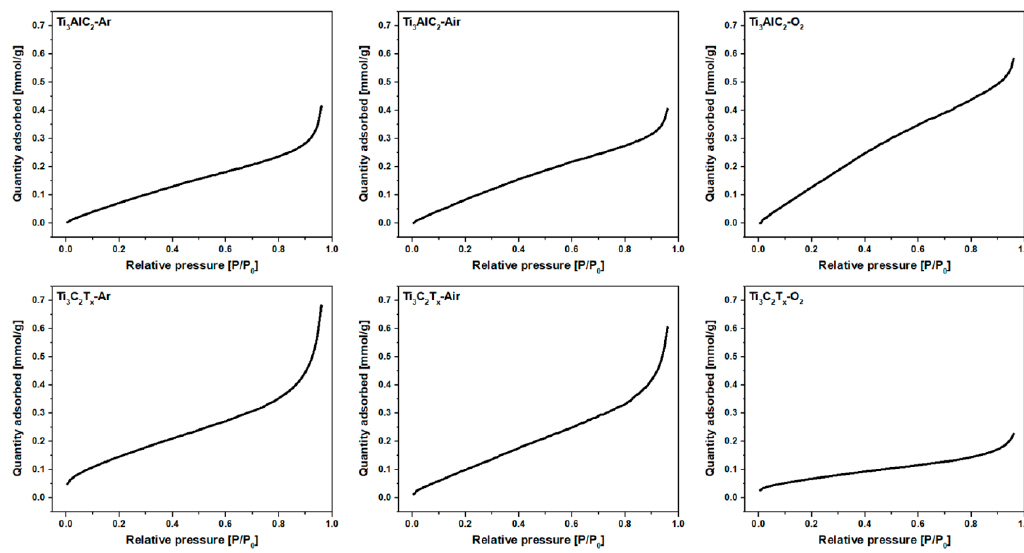
Figure 4. The N 2 adsorption isotherms of MAX phase and MXene powders.